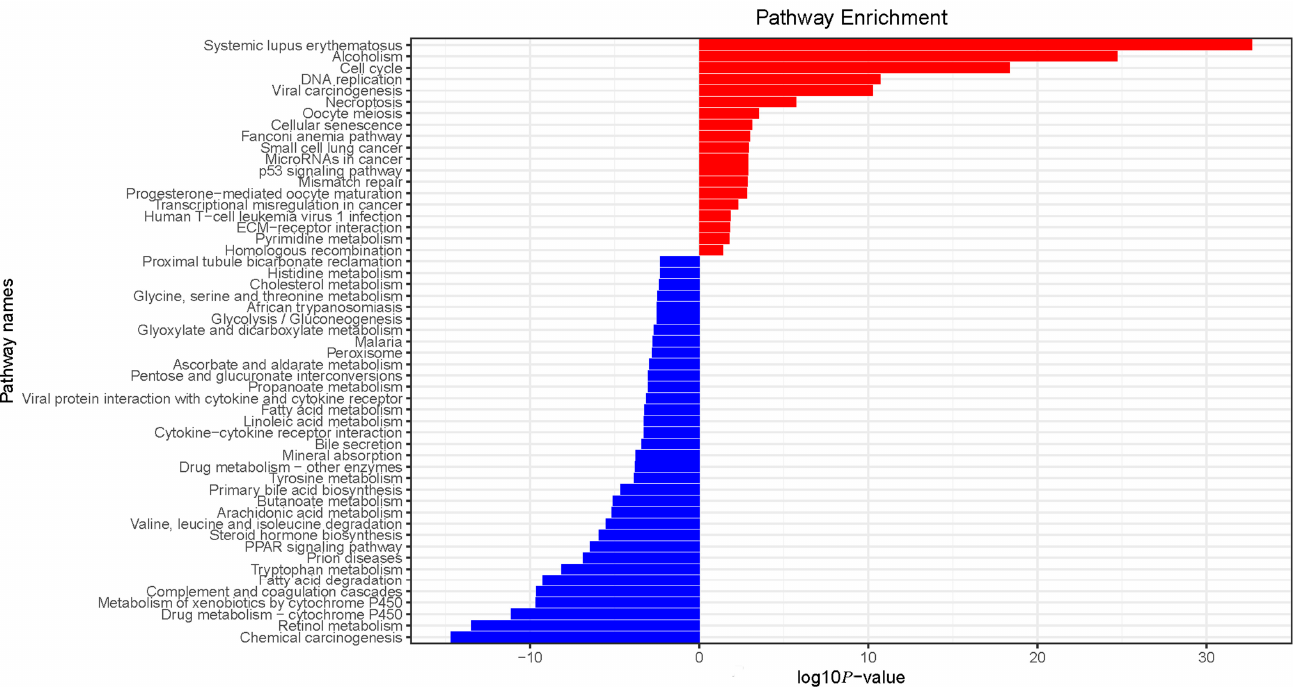
Figure 4. Gene Ontology enrichment analysis of downregulated mRNA between hepatocellular carcinoma and para-carcinoma tissues: ( A ) biological process, ( B ) cell component, ( C ) molecular function.